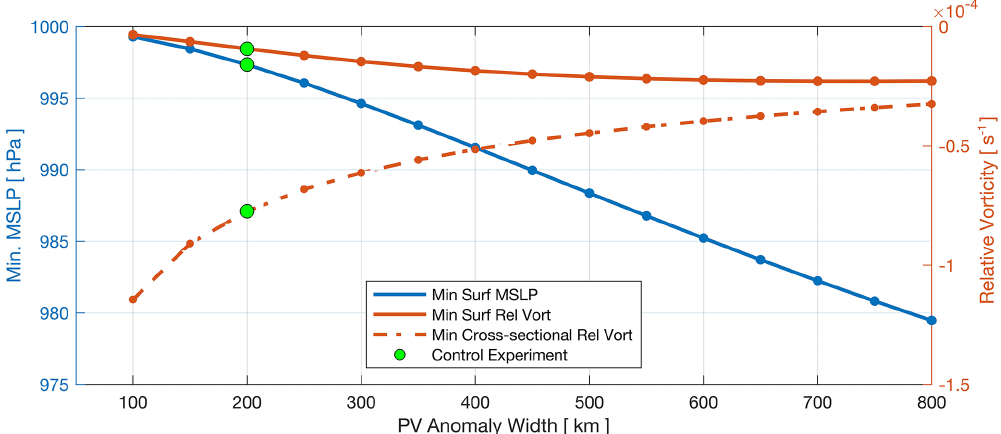
Figure 15. Same as in Fig. 8 but for Experiment 5 (varying anomaly radial width